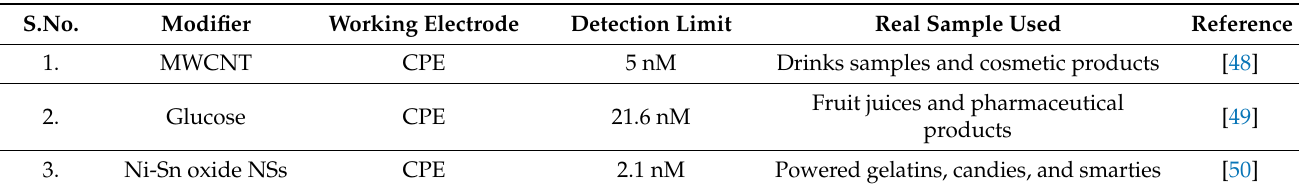
Figure 15. CV of ER at glucose modified carbon paste electrode and bare carbon paste electrode in pH 11.2 phosphate buffer (I = 0.2 M) at scan rate = 0.05 Vs − 1 . Reprinted with the permission of Reference [49]. [License Number 5067500649853]. Table 9. Table showing Erythrosine detection using carbon paste electrodes with different modifiers along with their detection